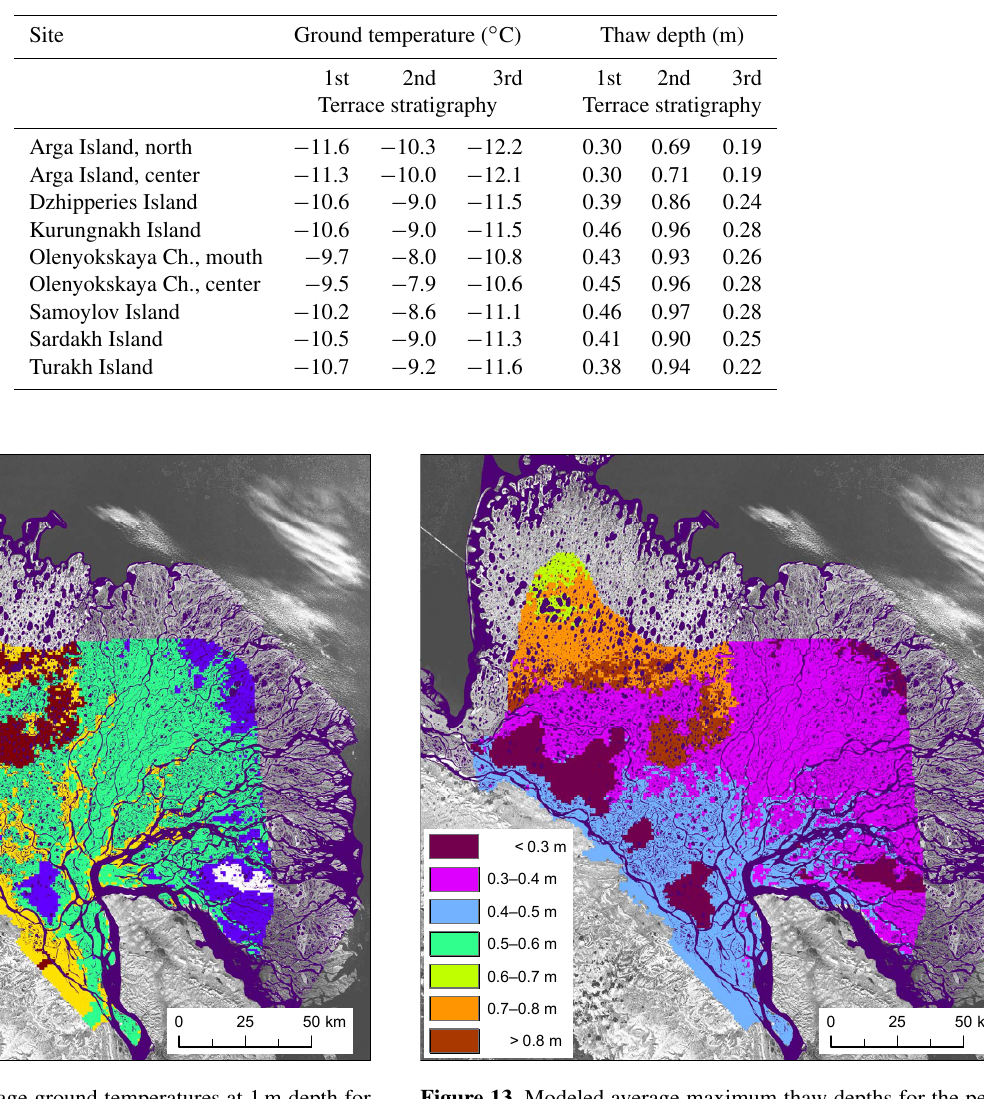
Figure 12. Modeled average ground temperatures at 1m depth for the period 2004–2013, with a snow density of 225kgm − 3 .